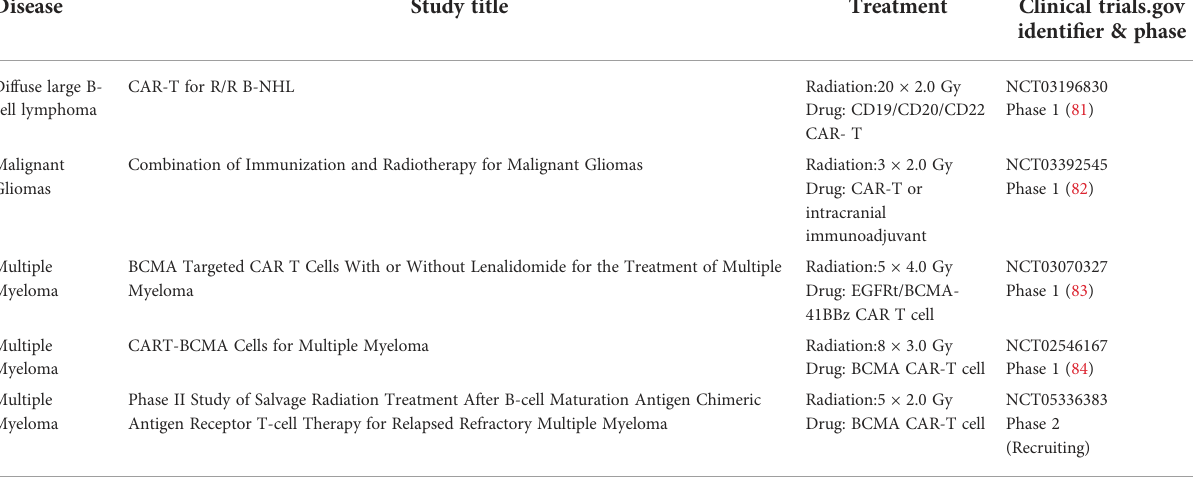
TABLE 2 Clinical studies of RT in combination with CAR-T cells (ClinicalTrials.gov). Disease Treatment Clinical trials.gov